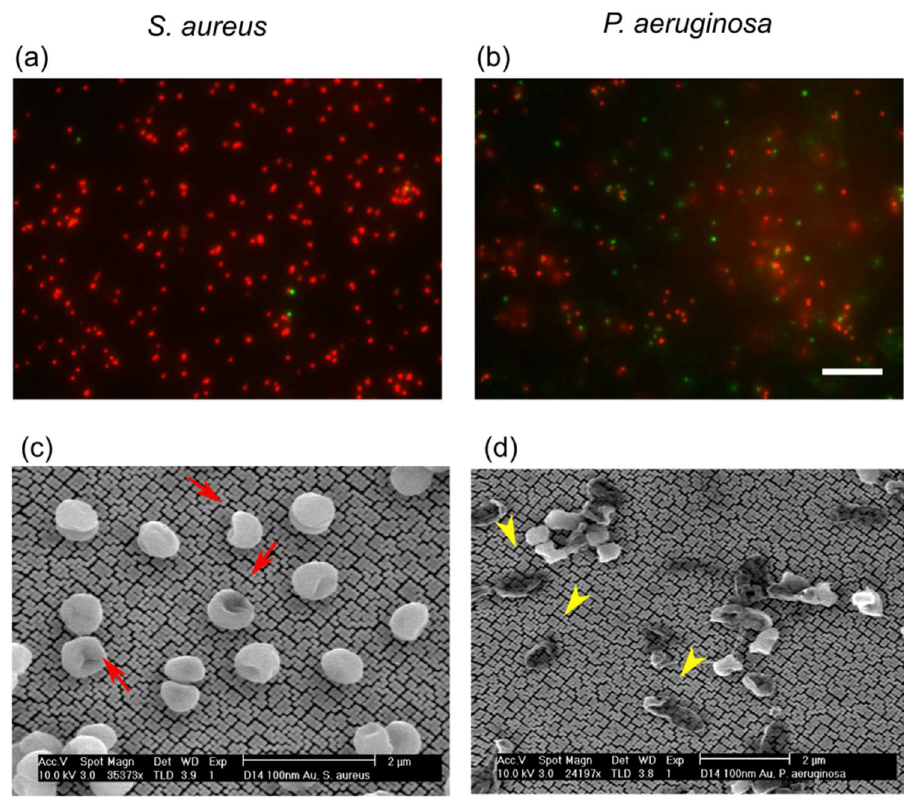
Figure 2. Cell lysis by cotton swab nanopillars. Micrographs from ( a–b ) the LIVE/DEAD assay and ( c–d ) SEM of S. aureus and P. aeruginosa cells incubated on 260 nm tall gold cotton swab nanopillars (100 nm deposition) for 18 h. Scale bar for fluorescence microscopy images correspond to 20 μm. Red arrows show collapsed and deformed S. aureus cells on the surface. Yellow arrowheads show P. aeruginosa cells engulfed by the nanopillars.